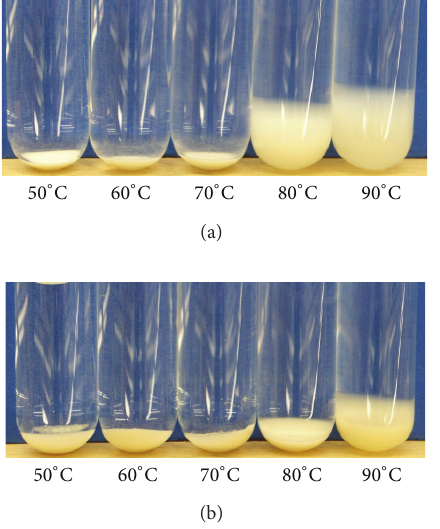
Figure 6: Swellability of (a) native JFS and (b) a representative HMT-JFS (JF-25-80-16), at various (50–90 ∘ C)